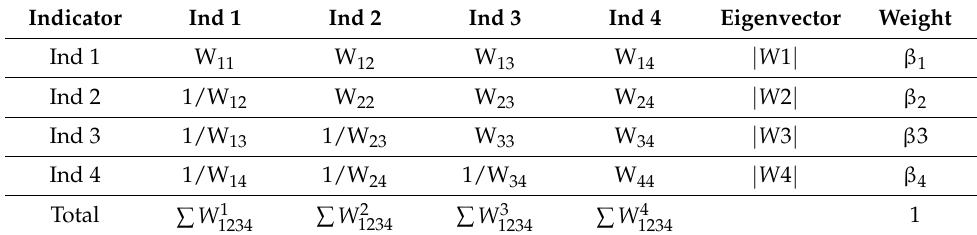
Table 2. Pairwise comparison matrix of three